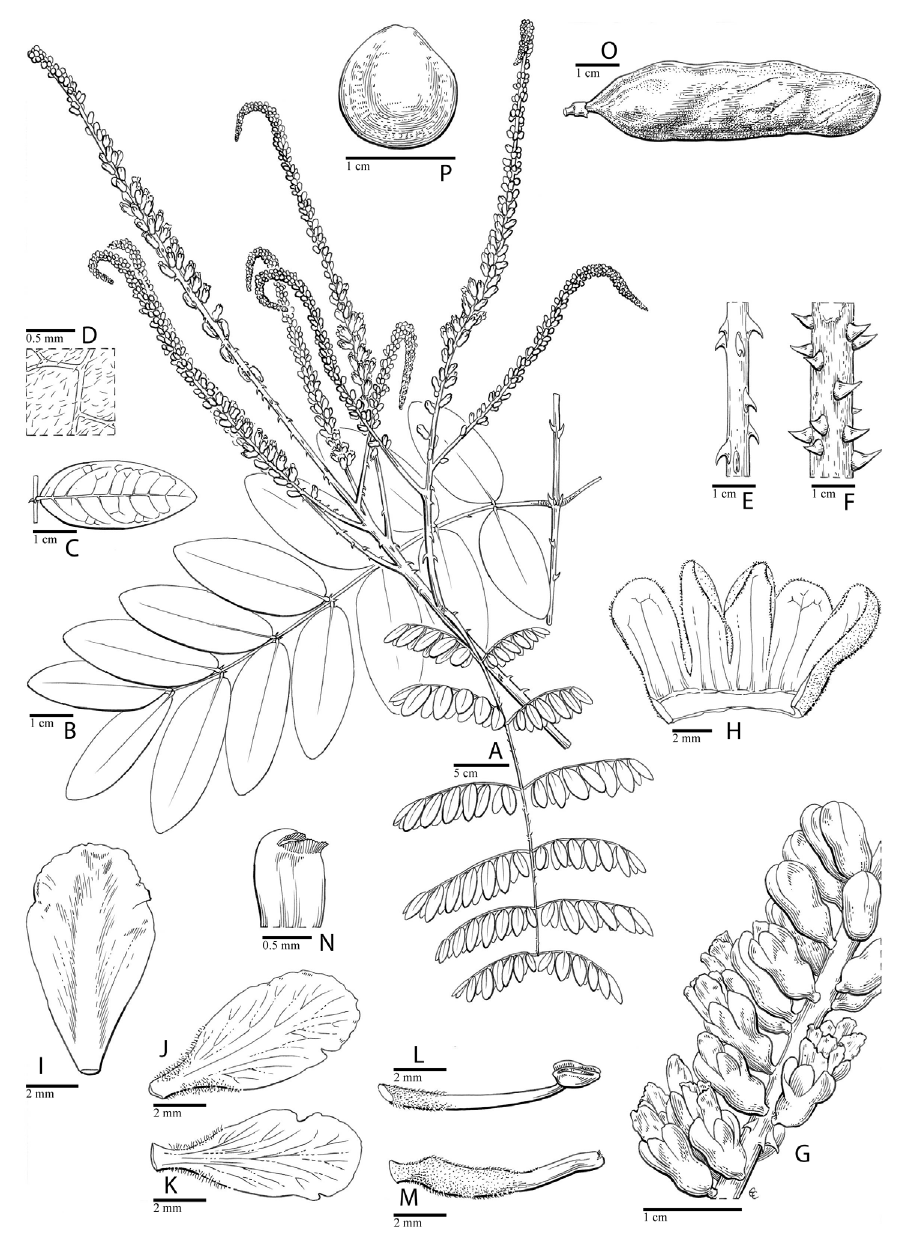
Figure 21. Moullava spicata (Dalzell) Nicolson. A flowering branch B single pinna of bipinnate leaf C leaflet undersurface D leaflet undersurface detail E young stem F older stem G part inflorescence H calyx opened out I median petal J upper lateral petal K lower lateral petal L stamen M gynoecium N stigma O fruit P seed. A , G from photo by P. S. Green B – D, H – N from Cult. Foster Bot. Gard. F1901, specimen Hutchinson 2784 E from Critchett 11/79 F from Nana 5620 O , P from Meebold 8605. Drawn by Eleanor